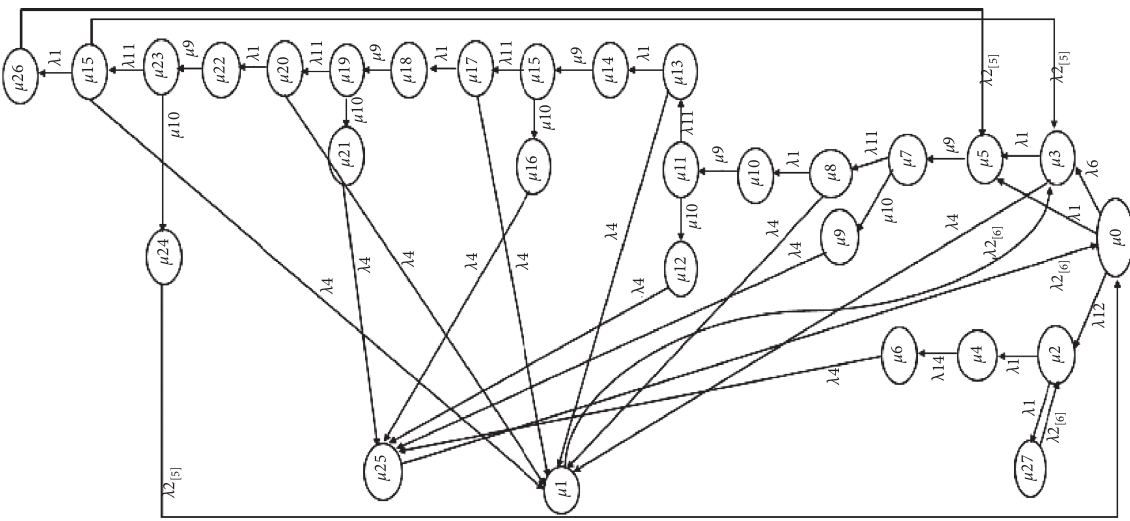
Figure 2: The graph of the associated Markov chain. Table 3: The parameters of the graph of the associated Markov